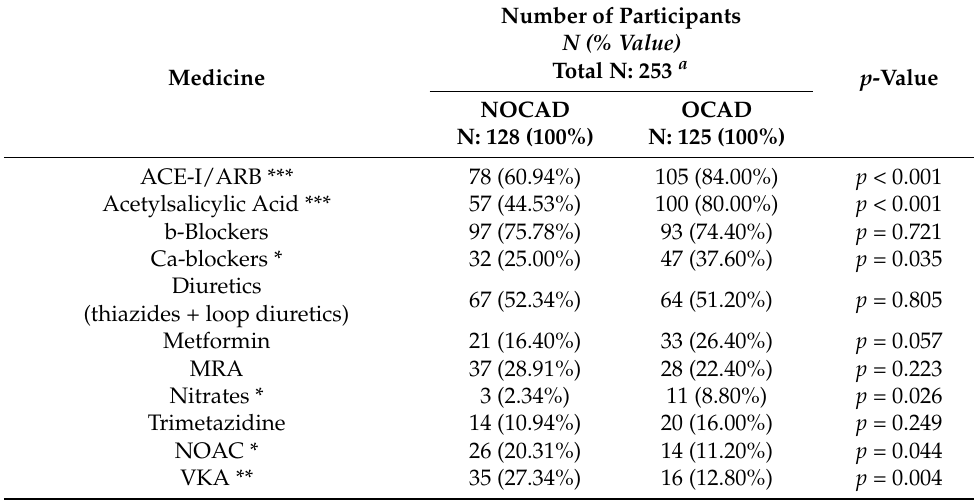
Table 4. Summary of pre-hospital medications in NOCAD and OCAD groups (excluding lipid- lowering drugs).